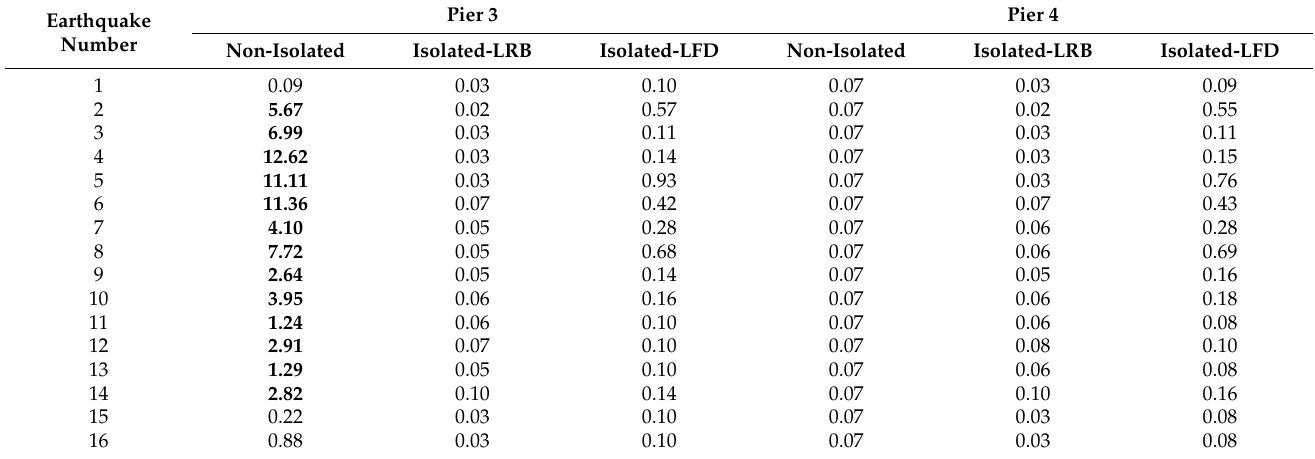
Table 2. The ratios of maximum pier curvature to yielding curvature for the three systems. Earthquake